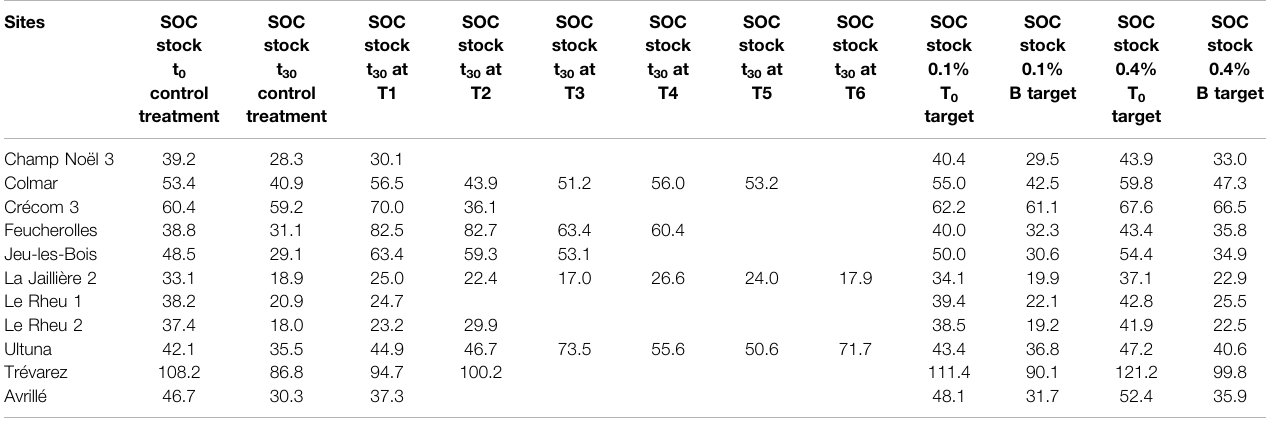
t 0 and t 30 indicate the 0th and the 30th year of the prediction, respectively. T1, T2, ... , T6 indicate the exogenous organic matter (EOM) treatments ’ identi fi cation code for each site (detailed description of the EOM treatments are provided in Supplementary Table S1 ). The target SOC stock level was calculated for a 0.1 and 0.4% average annual increase over 30 years, based on approach T 0 and B.